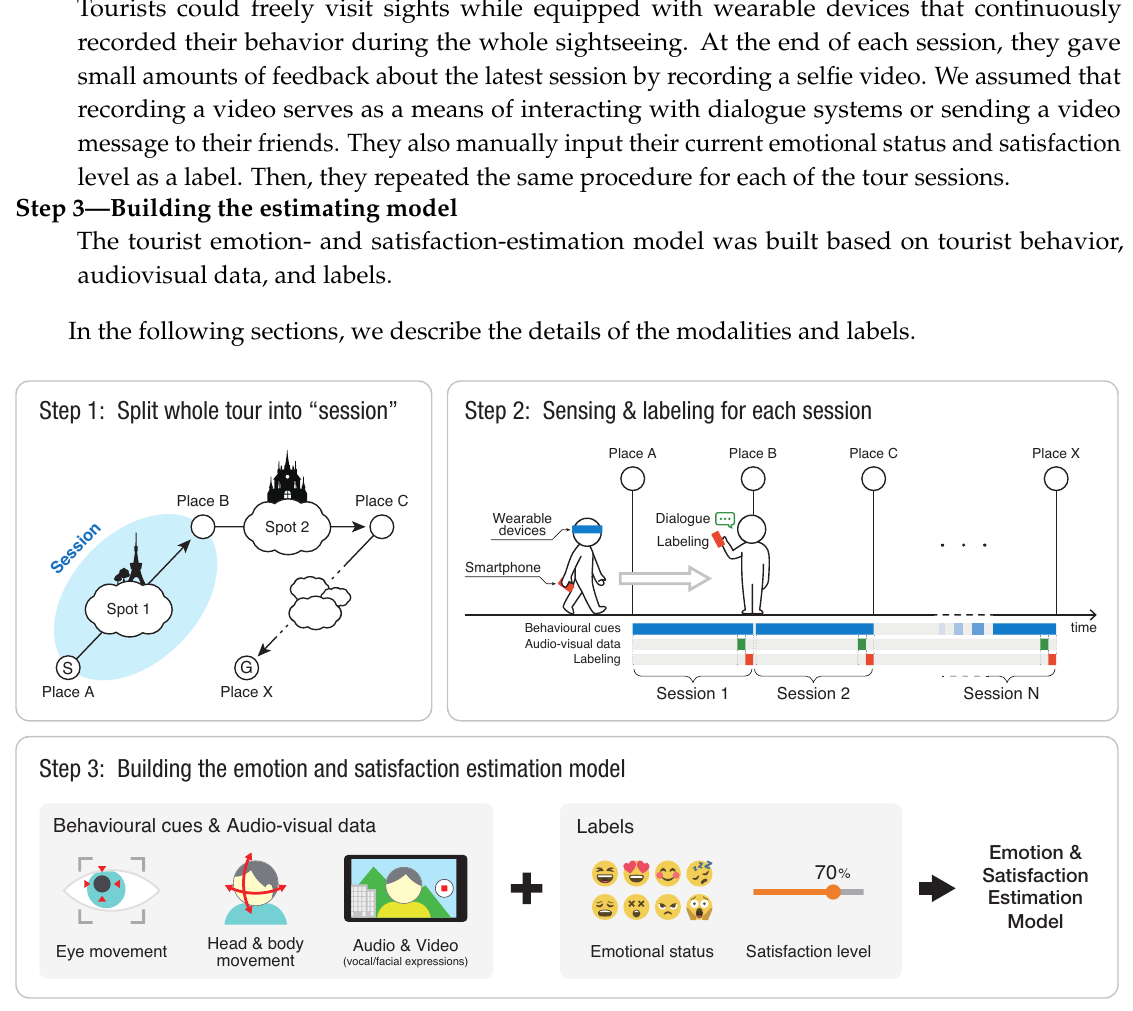
Figure 1. Workflow to estimate tourist emotion and satisfaction